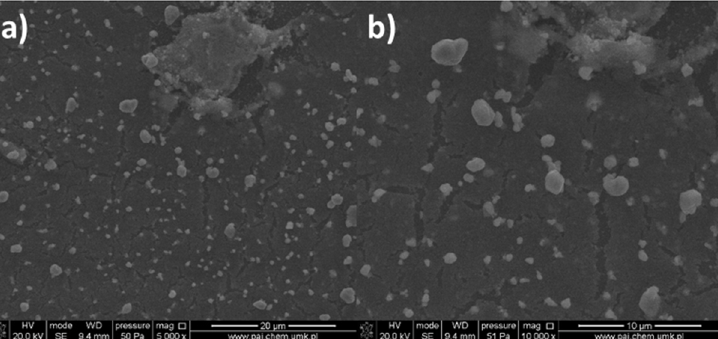
Figure 15. SEM images of [Cu 2 (EtNH 2 ) 2 (µ-O 2 CC 2 F 5 ) 4 ] ( 2 )/Si after heating, Cu 5.53 wt.%, O 10.48 wt.%, (800 rpm, 10 s, 600 rpm, 10 s × 2, drying 3000 rpm, 60 s) ( a ) Mag = 5000 × ( b ) Mag = 10,000 × .